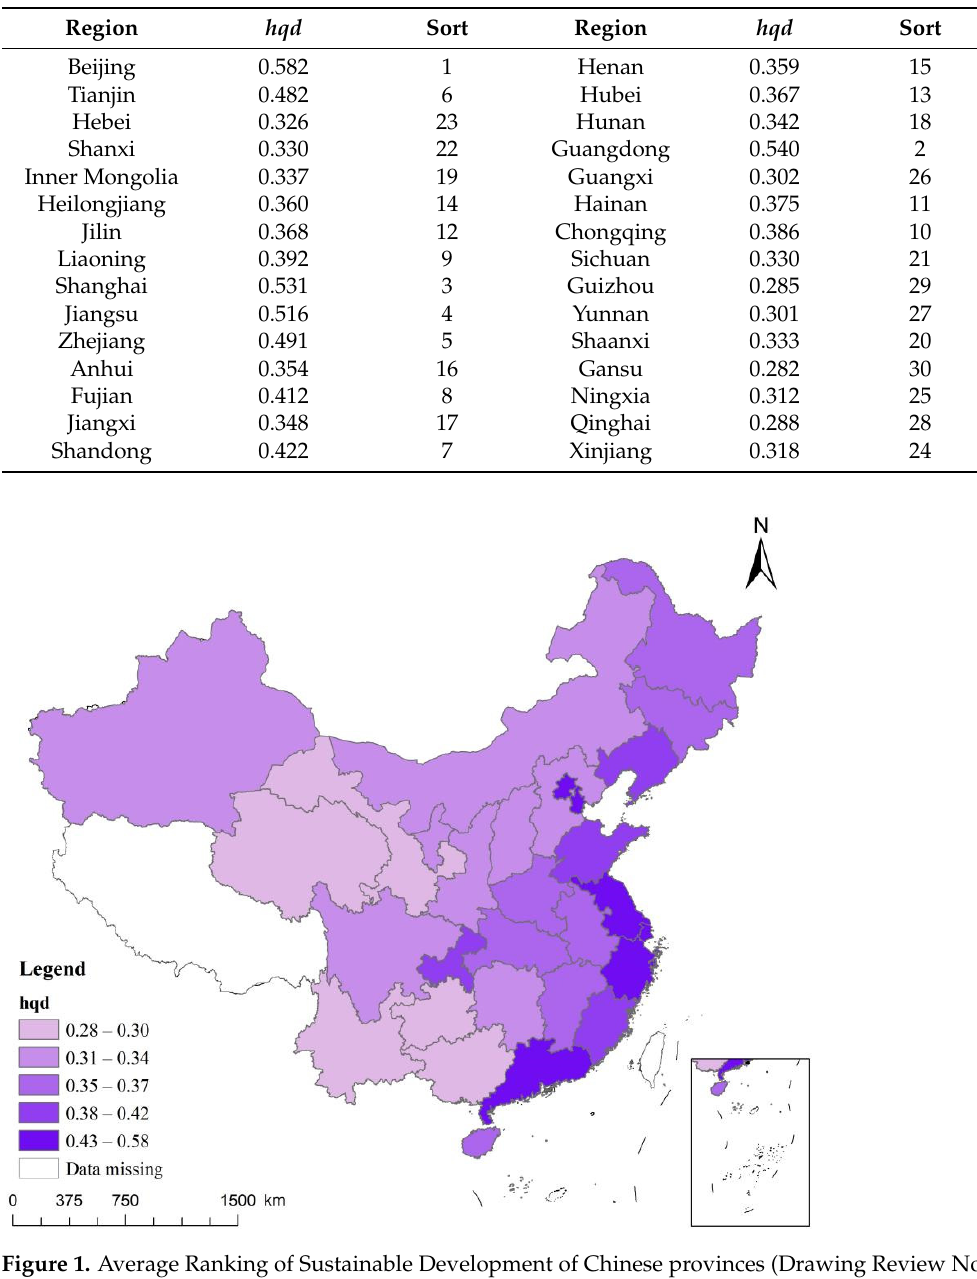
Table 3. The Regional High-Quality Development Index.